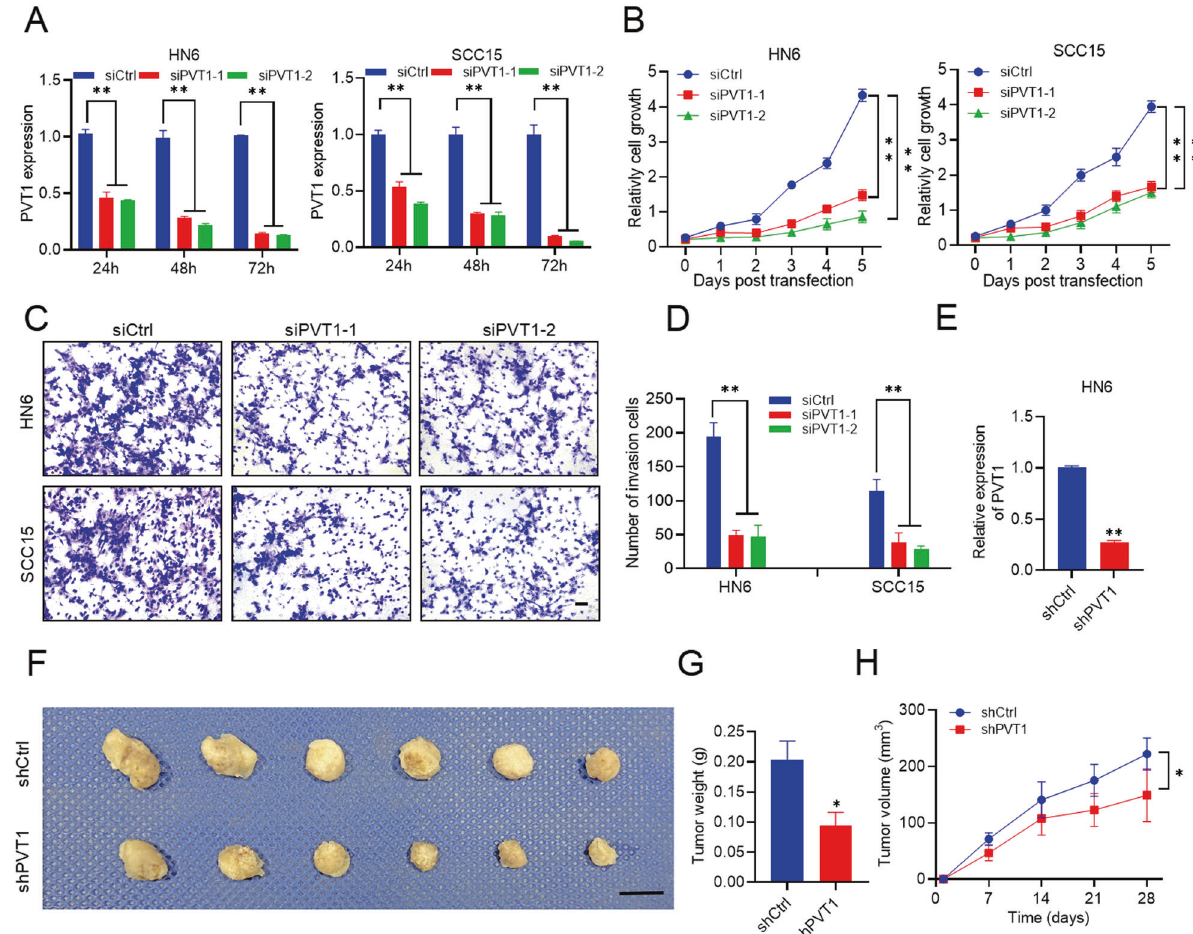
Fig. 2 Knockdown of PVT1 inhibits HNSCC proliferation and invasion. A qRT-PCR assessment of PVT1 expression in HN6 and SCC15 cells transfected with the siRNA control (siCtrl), siRNA PVT1-1 (siPVT1-1), and siRNA PVT1-2 (siPVT1-2) for 24, 48, and 72 h. Data are shown as the mean ± SD. ** p < 0.01 using an unpaired Student ’ s t-test. B The impact of PVT1 knockdown (KD) on HN6 and SCC15 cell proliferation. Data are shown as the mean ± SD. ** p < 0.01 using an unpaired Student ’ s t-test. C , D The impact of PVT1 KD on HN6 and SCC15 cell invasion after 24 h. Scale bar: 100 μ m. Data are shown as the mean ± SD. ** p < 0.01 using an unpaired Student ’ s t-test. E qRT-PCR assessment of PVT1 expression in HN6 cells infected with shRNA control (shCtrl) and shRNA PVT1 (shPVT1). Data are shown as the mean ± SD. ** p < 0.01 using an unpaired Student ’ s t-test. F Image of the nude mice subcutaneous tumor model established using HN6 cells with PVT1 KD. Scale bar: 1 cm. G The weight of PVT1 KD HN6 tumors in nude mice. Data are shown as the mean ± SD ( n = 6). * p < 0.05 using an unpaired Student ’ s t-test. H The volume of PVT1 KD HN6 tumors in nude mice. Data are shown as the mean ± SD ( n = 6). * p < 0.05 using an unpaired Student ’ s